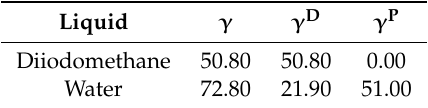
Table 2. Surface tension components of the reference liquids (mJ/m 2 ) [41].